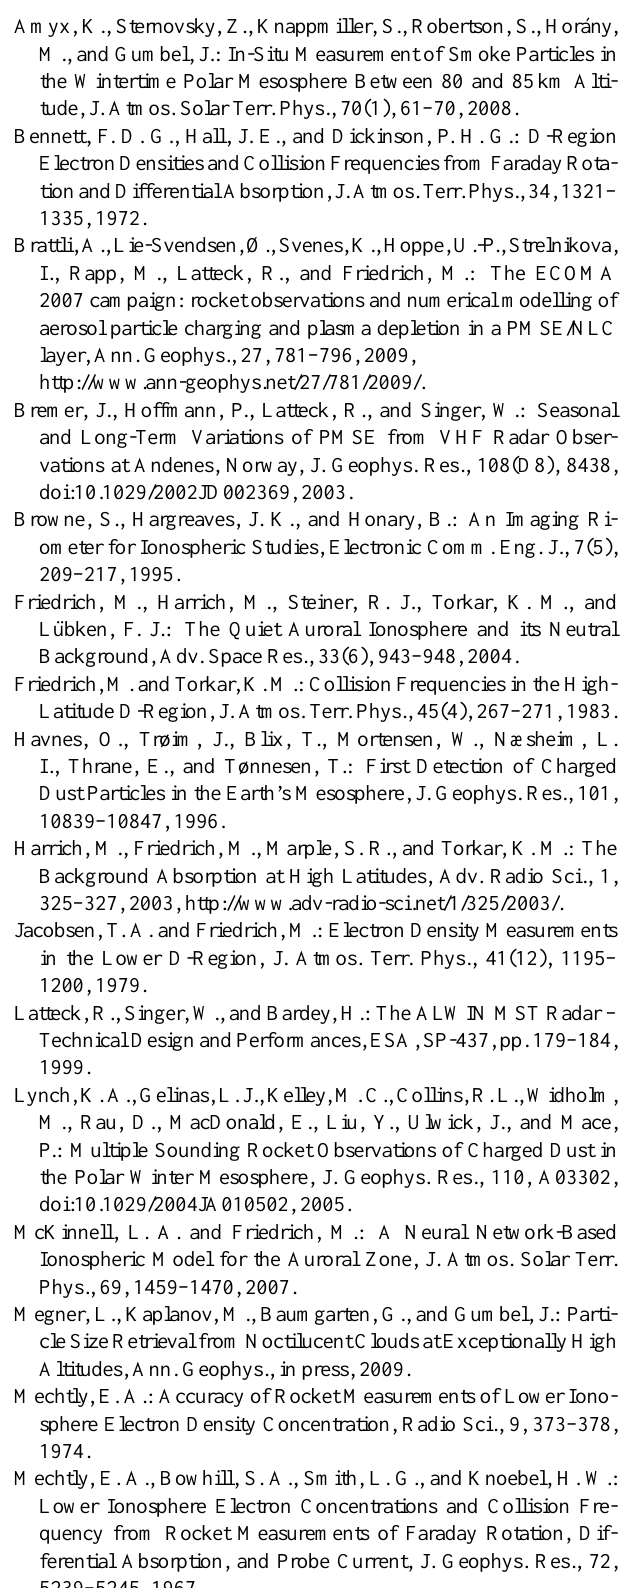
Table 1. Absorption calculations to correct the